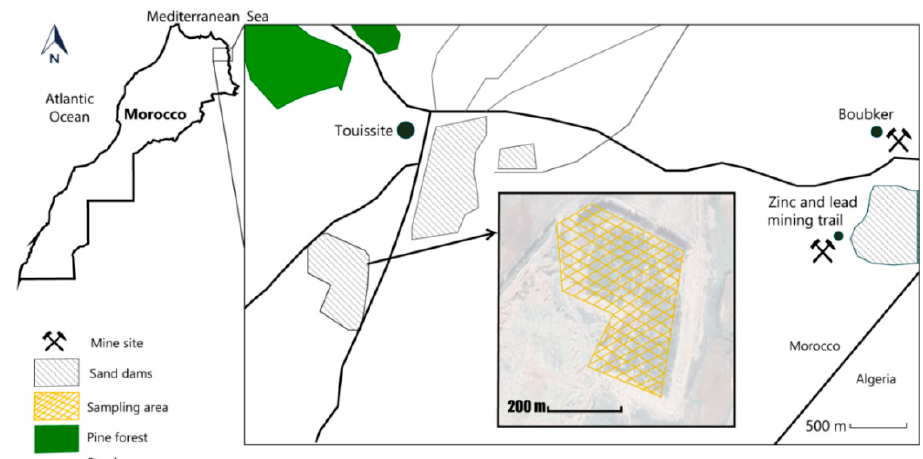
Figure 2. Plant and soil sampling area at Touissite site.